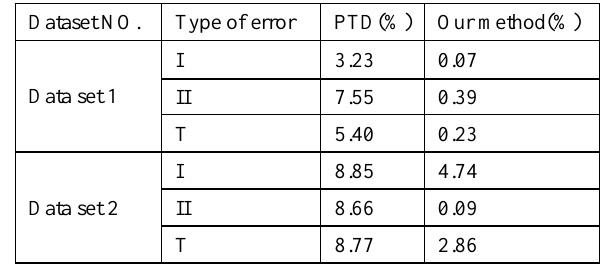
Table 3. Three types of errors of the two filters in the two test